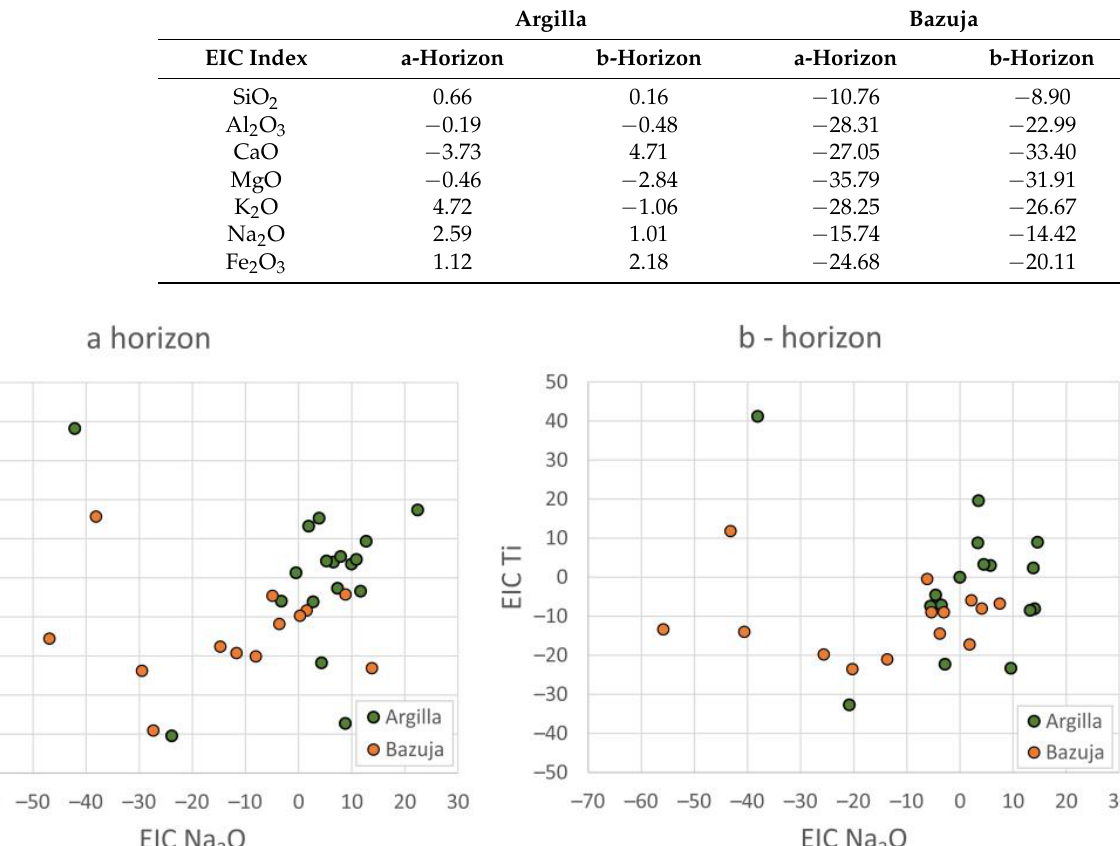
Figure 4. Distribution of calculated EIC Na 2 O compared with EIC Ti in a and b soil horizons in the rivers’ Argilla and Bazuja’s catchments.